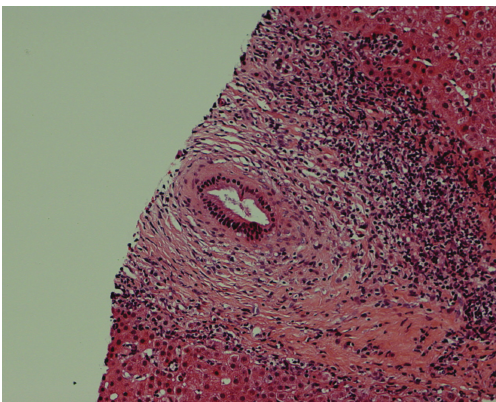
Figure 3: Concentric fibrosis and portal tract inflammation (inter- mediatepower view).